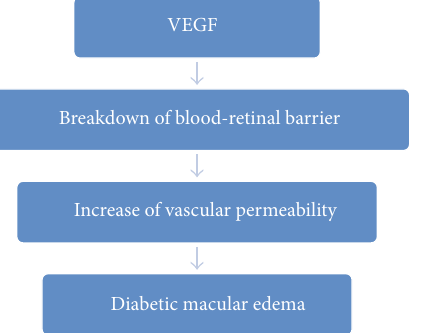
Figure 3: VEGF and pathophysiology of diabetic macular edema.